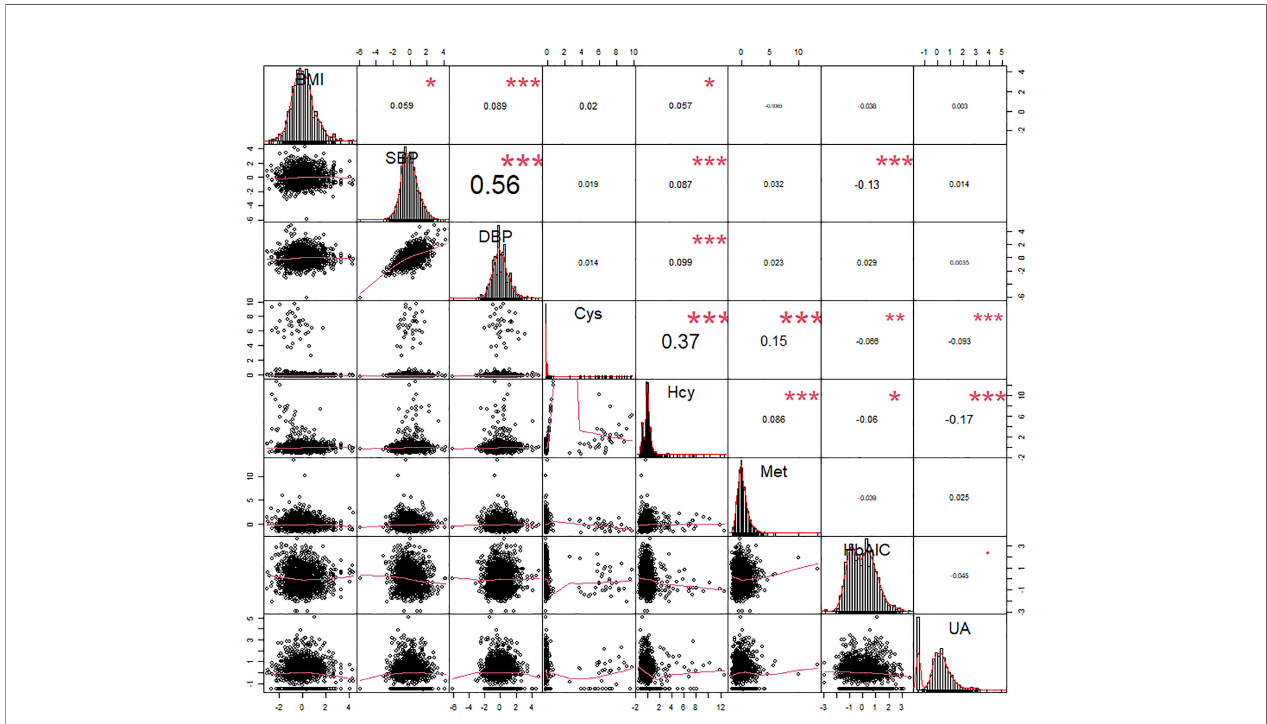
FIGURE 3 | Spearman correlation coef fi cients and probability density plots between plasma Hcy and risk factors of DR (n=1797). BMI, body mass index. SBP, systolic blood pressure. DBP, diastolic blood pressure; HbAlc, glycated hemoglobin; Hcy, Homocysteine; Met, Methionine; Cys, Cysteine; UA, uric acid. *p-value <0.05, **p-value <0.01, ***p-value